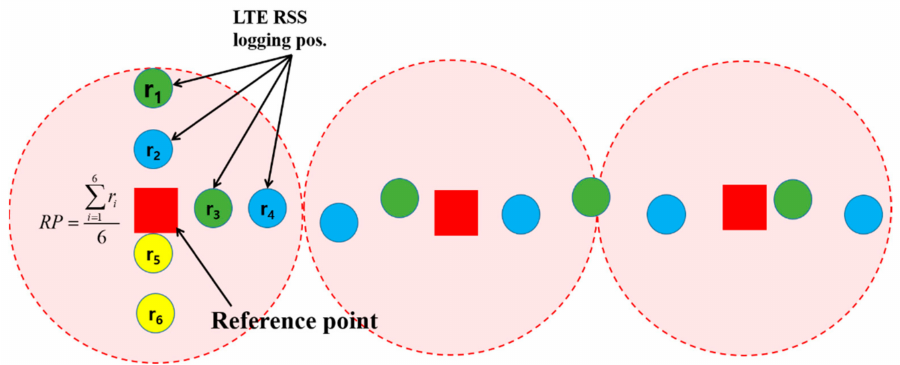
Figure 6. Calculation of RP value using LTE RSS collected